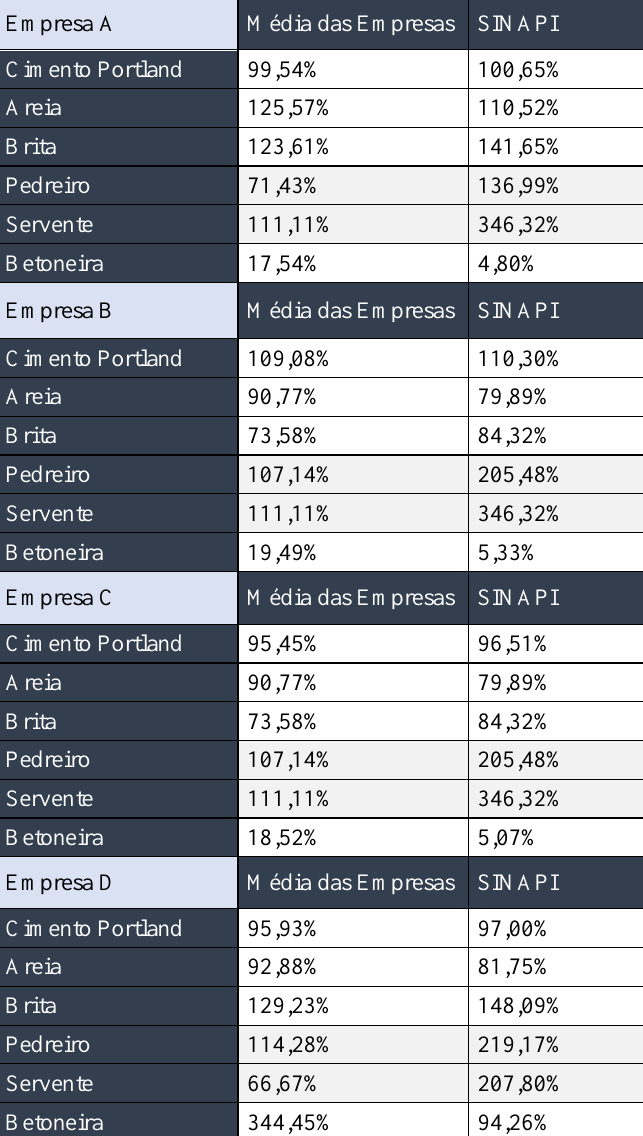
Tabela 6: Análise percentual dos índices de produção de concreto (Média e